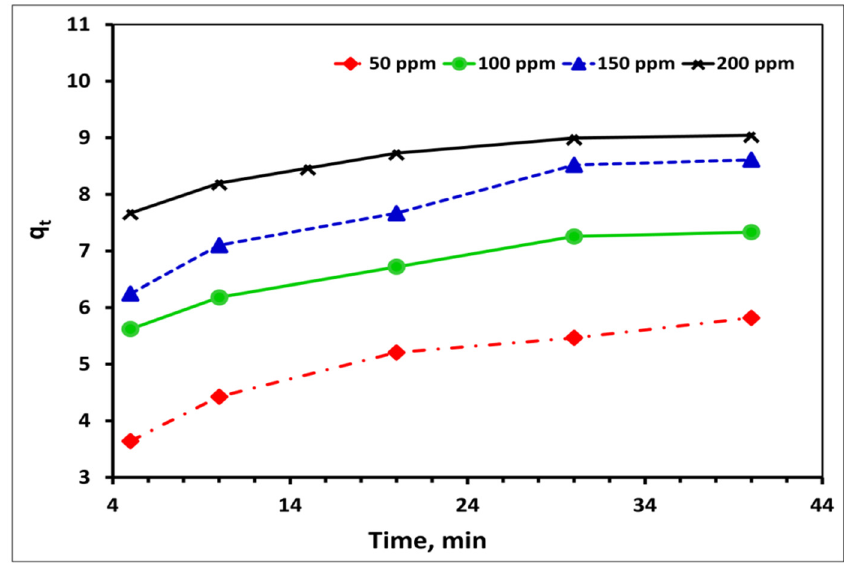
Figure 6. Effect of contact time on q t during the removal of cobalt by ZrO 2 NPs570 ( λ = 667, Volume: 50 mL, Conc.: 50–200 ppm, pH: 6.5, ZrO 2 mass: 0.3 g).